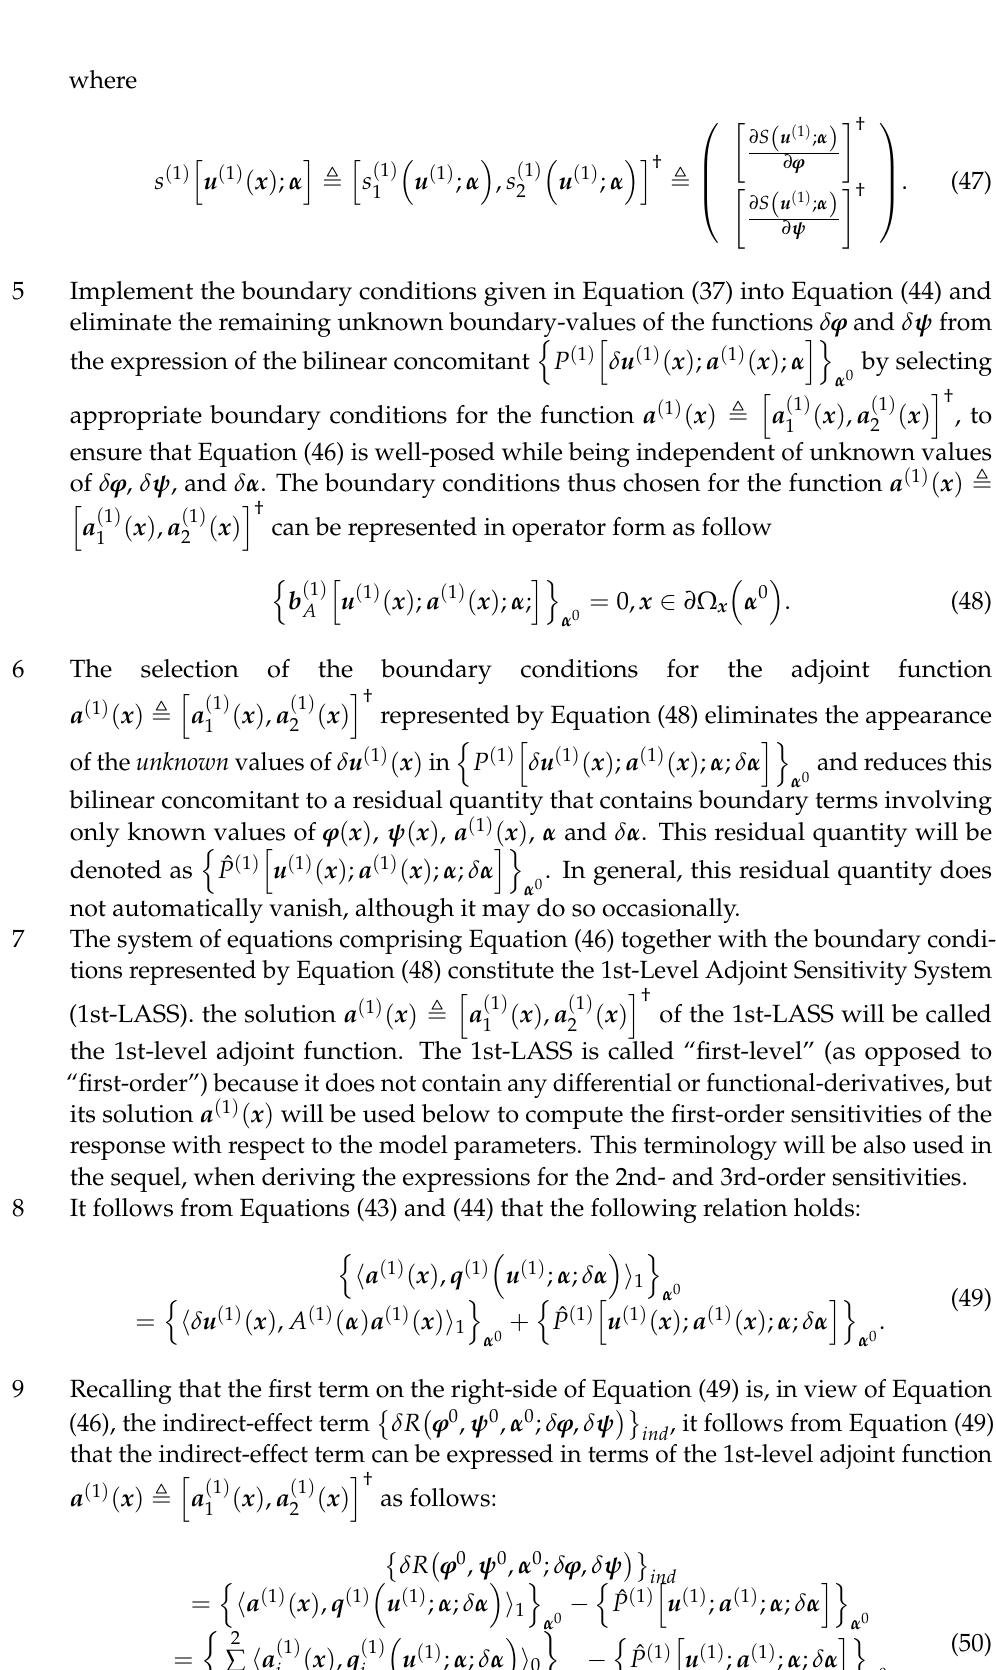
eliminate the remaining unknown boundary-values of the functions δ ϕ and δ ψ from the expression of the bilinear concomitant appropriate boundary conditions for the function a ( 1 ) ( x ) (cid:44) ensure that Equation (46) is well-posed while being independent of unknown values of δ ϕ , δ ψ , and δ α . The boundary conditions thus chosen for the function a ( 1 ) ( x )